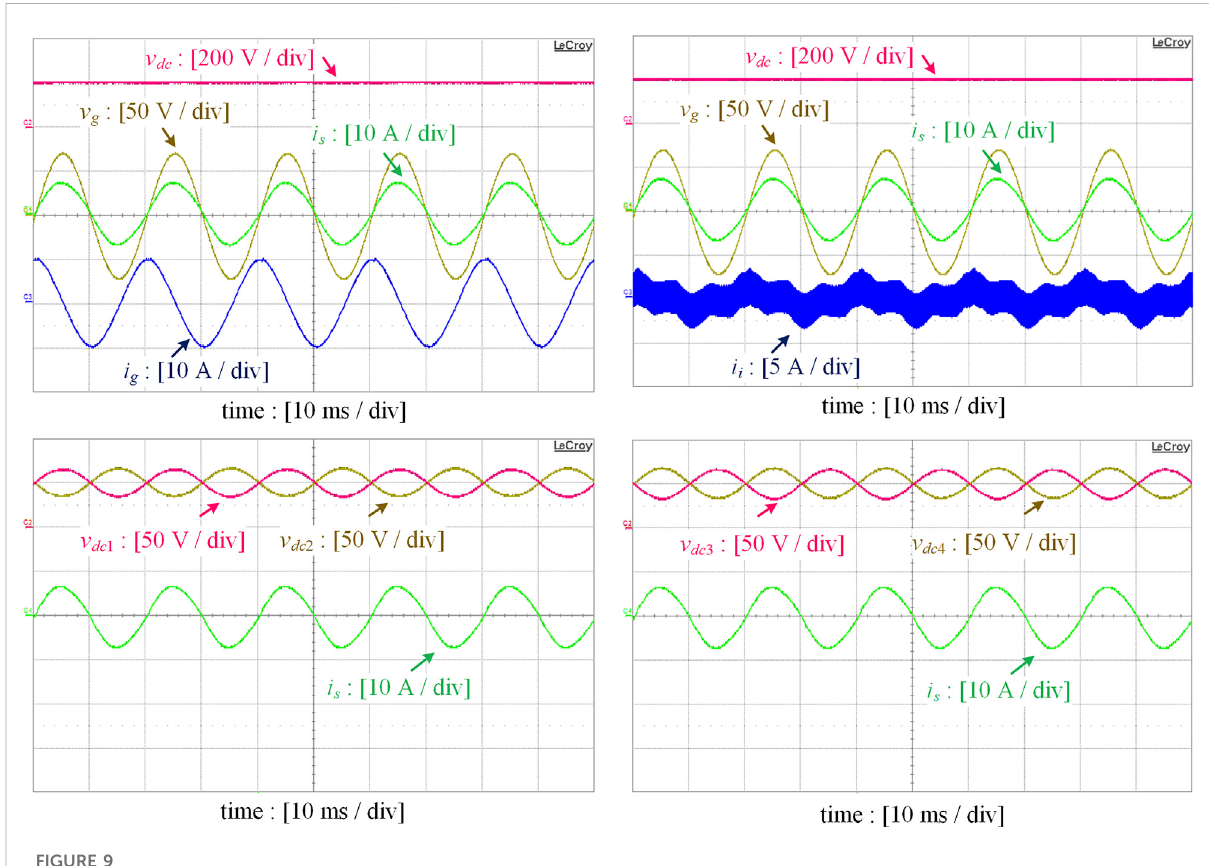
FIGURE 9 Experimental waveforms with reactive power compensated by the proposed DSTATCOM.